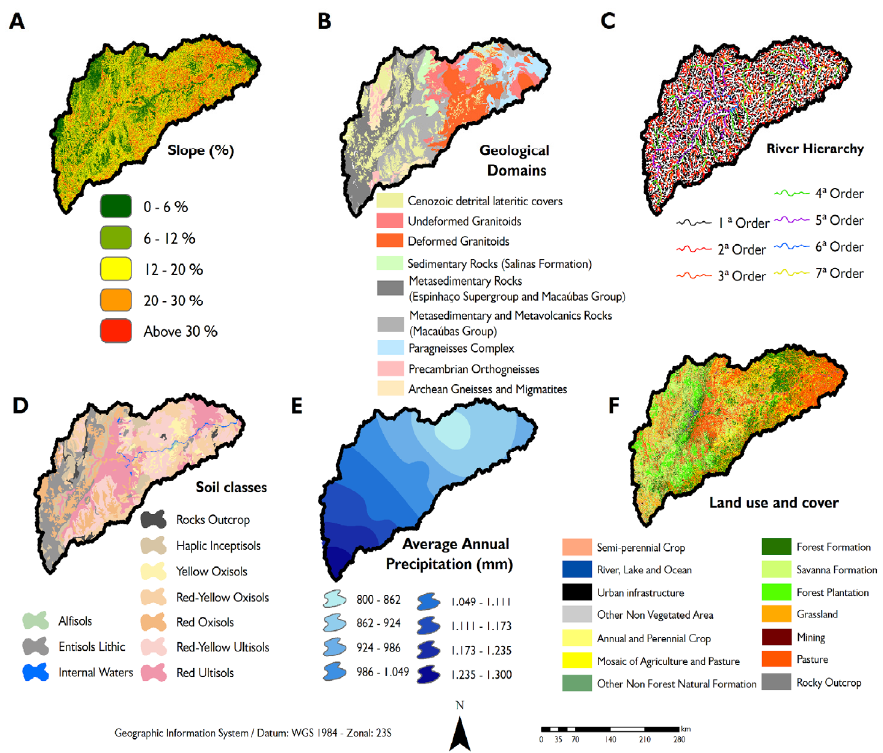
Figure 3. Information plans used in the algebra maps for the potential and emergent environmental fragility of the Jequitinhonha River Hydrographic Basin. Layers ( A ) slope; ( B ) geological domains; ( C ) river hierarchy; ( D ) soil classes; ( E ) average annual precipitations and ( F ) land use and cover.